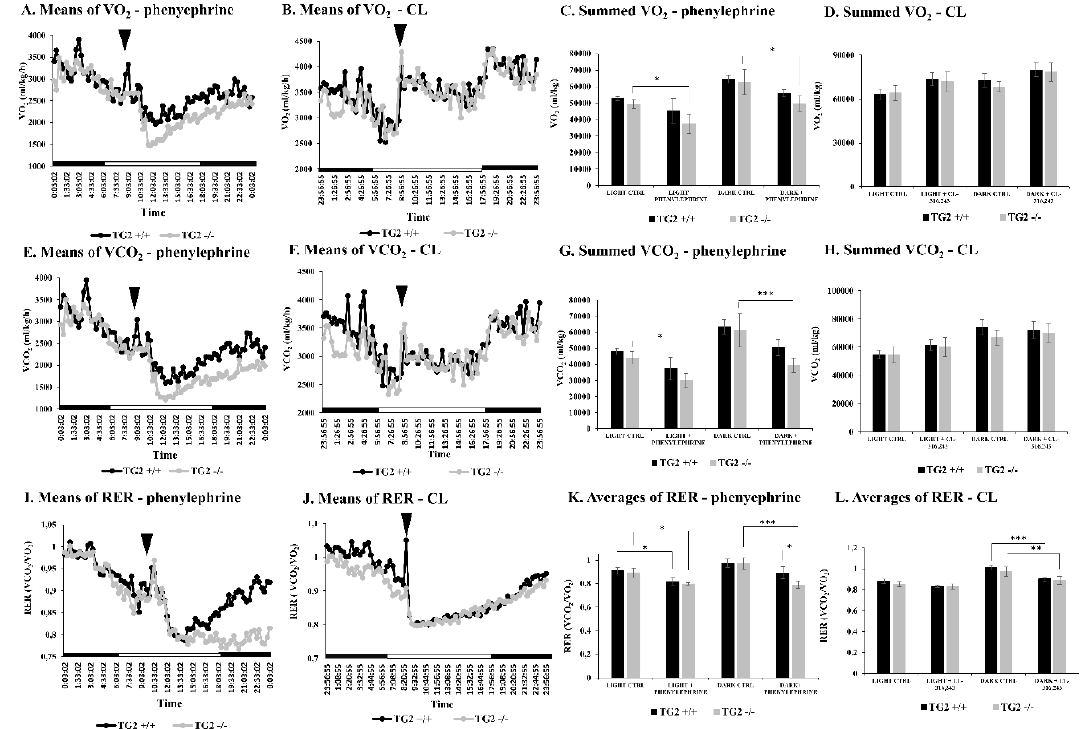
Figure 2. Treatment with the alpha1-AR agonist leads to a significant decrease in the respiratory exchange ratio (RER) of TG2 -/- mice compared to TG2 +/+ animals. Mean values of ( A , B ) O 2 consumption (VO 2 ), ( E , F ) CO 2 production (VCO 2 ), and ( I , J ) average values of the respiratory exchange ratio (RER) are presented before and after the treatment with ( A , E , I ) phenylephrine or ( B , F , J ) CL over the time ( n = 6). Arrowheads show the time point (9:00 a.m.) when the injection was carried out (60 nM/g body weight for both compounds). Day (□) and night ( ■ ) periods are indicated on the “X” axes. Summed values of ( C , D ) VO 2 , ( G , H ) VCO 2 and the average values of ( K , L ) RER are shown before (CTRL) and after the corresponding treatment for both in the light (9:03 a.m.–6:00 p.m.) and the dark (6:01 p.m.–6:00 a.m.) periods. Columns represent the mean values ± SD ( n = 6). Statistical analyses were carried out using GraphPad Prism 7.0 version, by two-way ANOVA (Tukey’s multiple comparison test; * p < 0.05, ** p < 0.01 and *** p < 0.001).